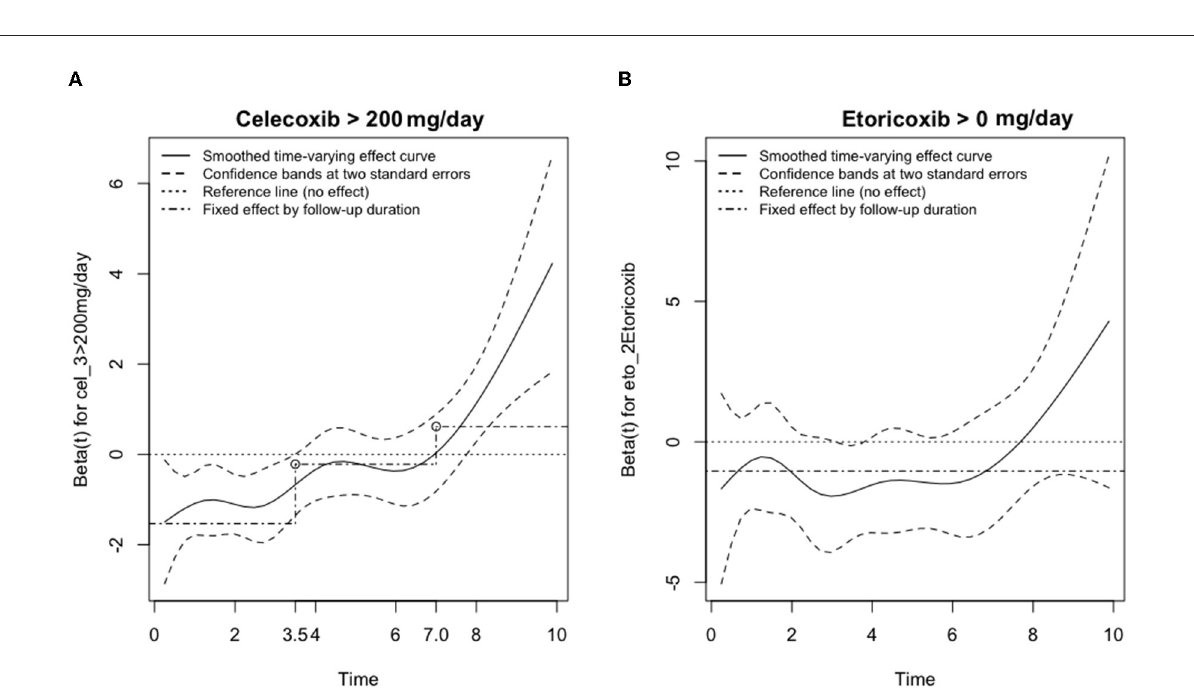
FIGURE3 Adjusted effects on the risk of ischemic stroke for the usage of (A) Celecoxib or (B) Etoricoxib vs. time (in years). The smoothed time-varying adjusted effect curve is based on the scaled Schoenfeld residuals plot (solid), along with the confidence bands at two standard errors (dashed), the reference line (dotted) and the time-fixed effects estimated from the Cox model (dash-dotted) for NSAID dosage of (A) Celecoxib > 200 mg/day and (B) Etoricoxib > 0